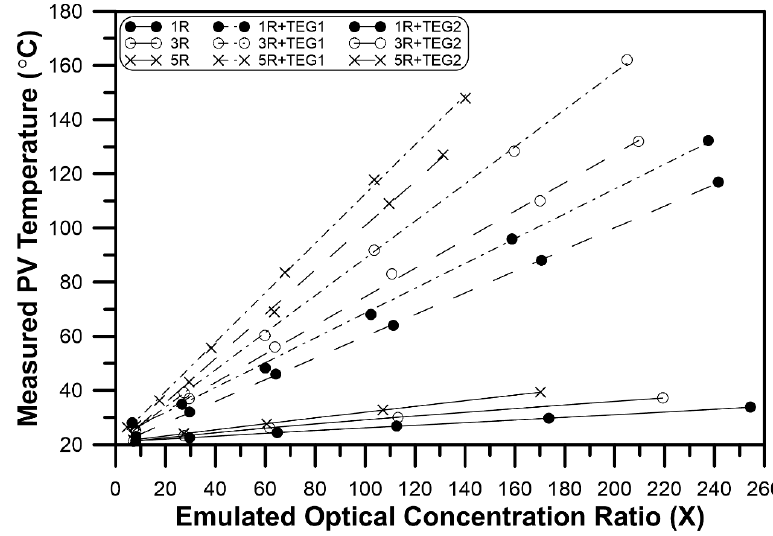
Figure 6. PV cells’ temperature increased as a function of the increasing inputted heat power.